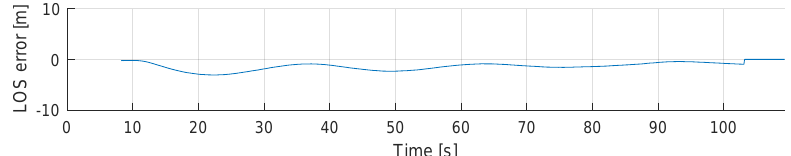
Figure 19. USV Control scenario: LOS cross-track error e ( t ) for the lookahead-based steering law defined in (22). This error is produced by the environmental variables, as the drift angle β is not included in the LOS-based guidance